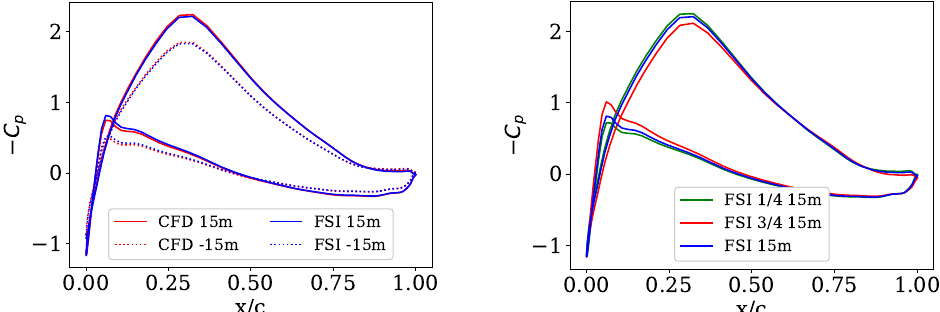
Figure 19. Chordwise pressure distributions for (C2) crosswind flight with logarithmic inflow at the chord 15 m and − 15 m from the center of the